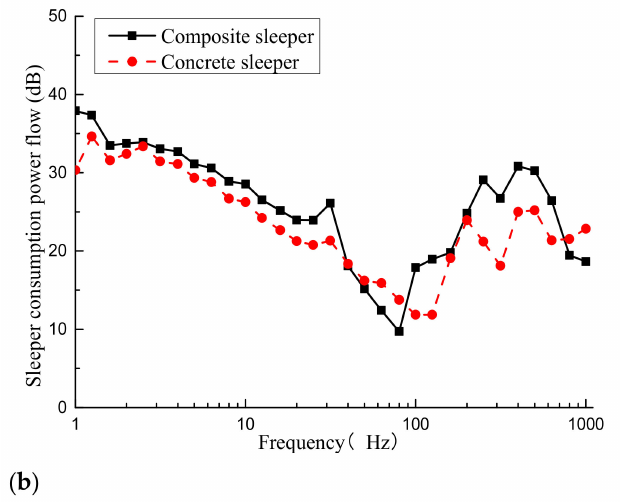
Figure 9. Sleeper power flow: ( a ) sleeper input and output power flow; ( b ) sleeper consumption power